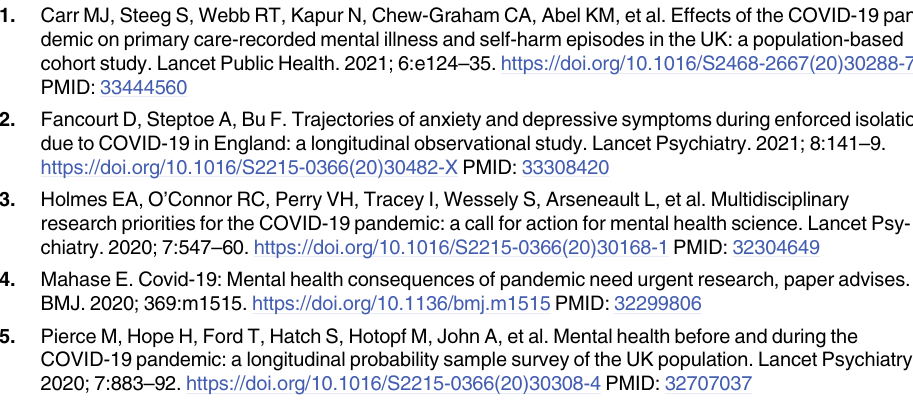
S2 Fig. Daily changes in COVID-19 policy responses (stringency index) in England from